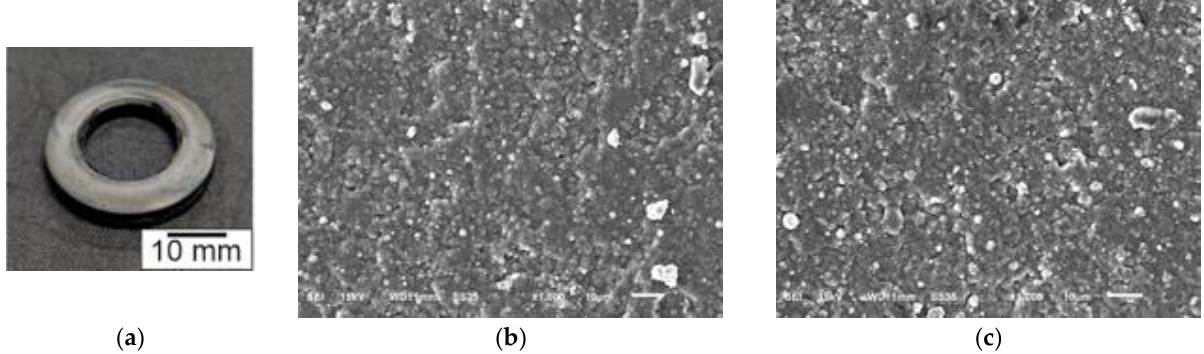
Figure 14. St-B-noCr-C sample: ( a ) overall appearance after exposure; ( b ) Surface morphology before exposure; ( c ) Surface morphology after exposure.